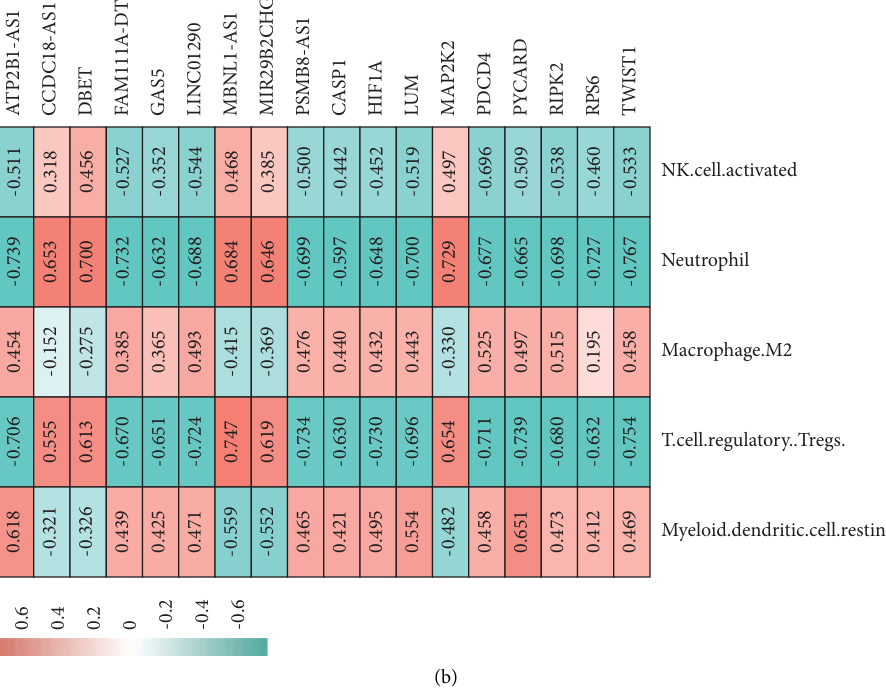
Figure 6: Correlation between immune cell types and the factors in the lncRNA-mRNA pathway network. (a) Proportion of the various immune cell types in the DMD samples and normal control subjects. (b) Correlation analysis between the fve signifcantly diferent immune cell types (in patients with DMD and control individuals) and the factors (DELs and DMD-related DEMs) in the lncRNA-mRNA pathway